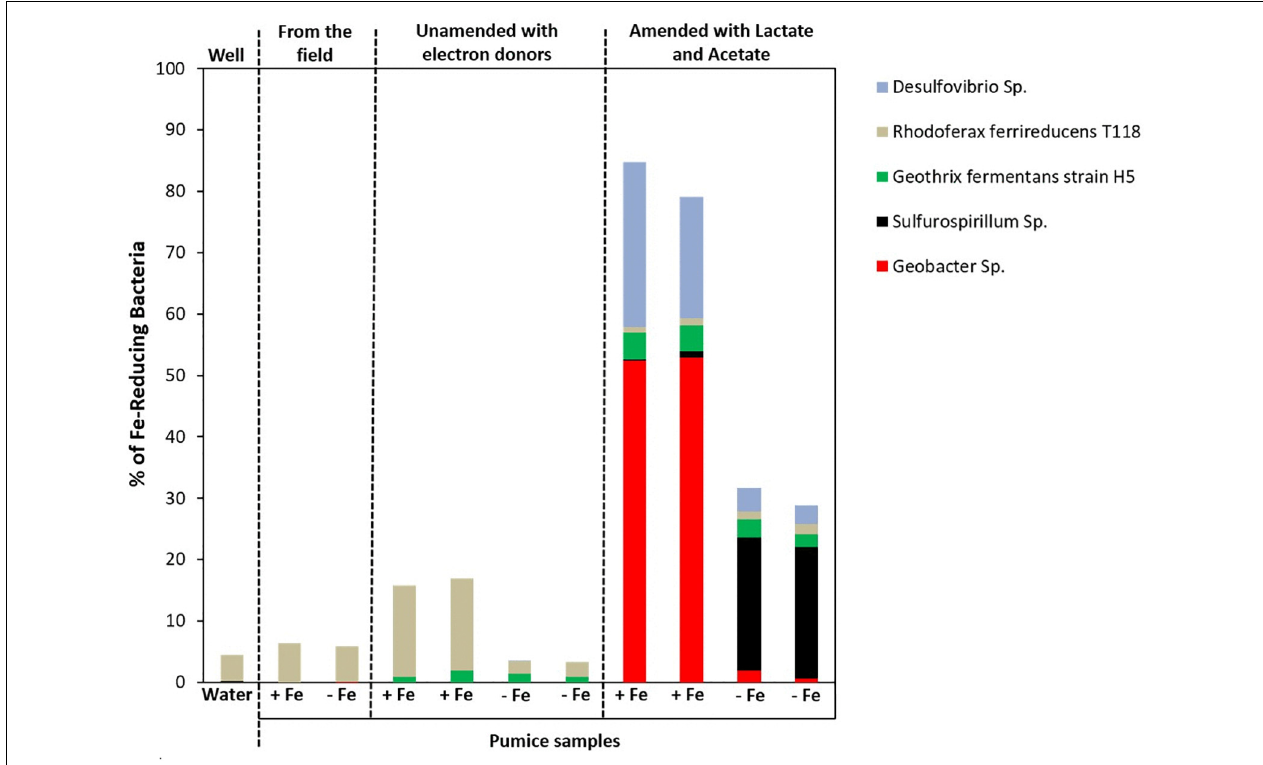
FIGURE 8 | Microbial community (Genera) in spring water and deployed pumice samples incubated (with and without electron donors) for 8 weeks at 20 ◦ C. +Fe represents Fe(III)-coated pumice and –Fe depicts uncoated pumice. Duplicates of each pumice sample were